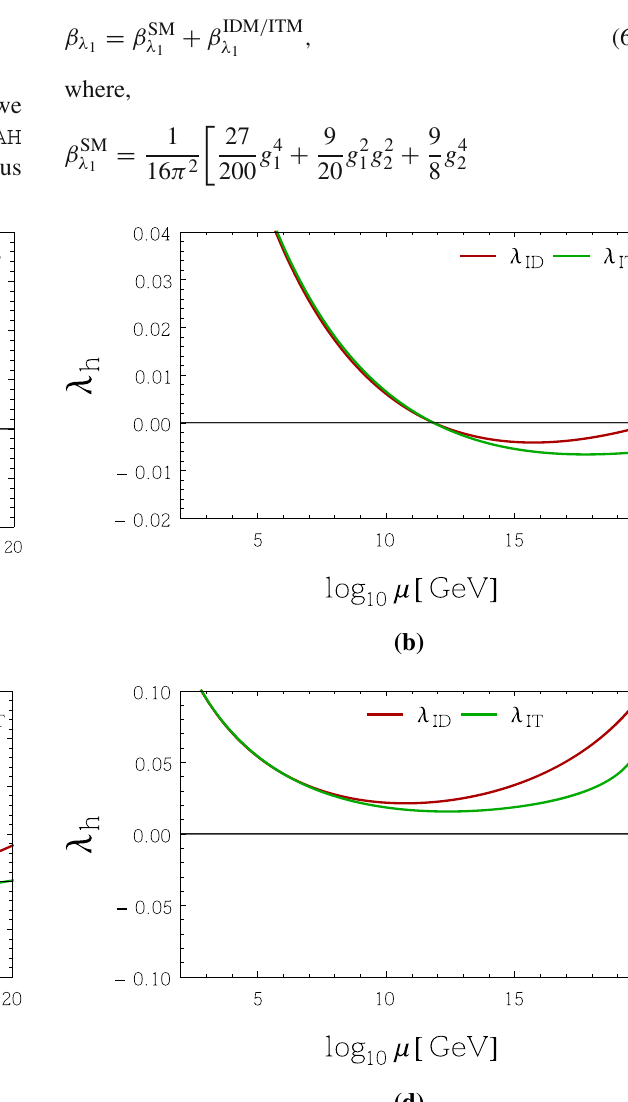
0.100 respectively. Here the red curve corresponds to the inert 2HDM and the green curve corresponds to the inert triplet